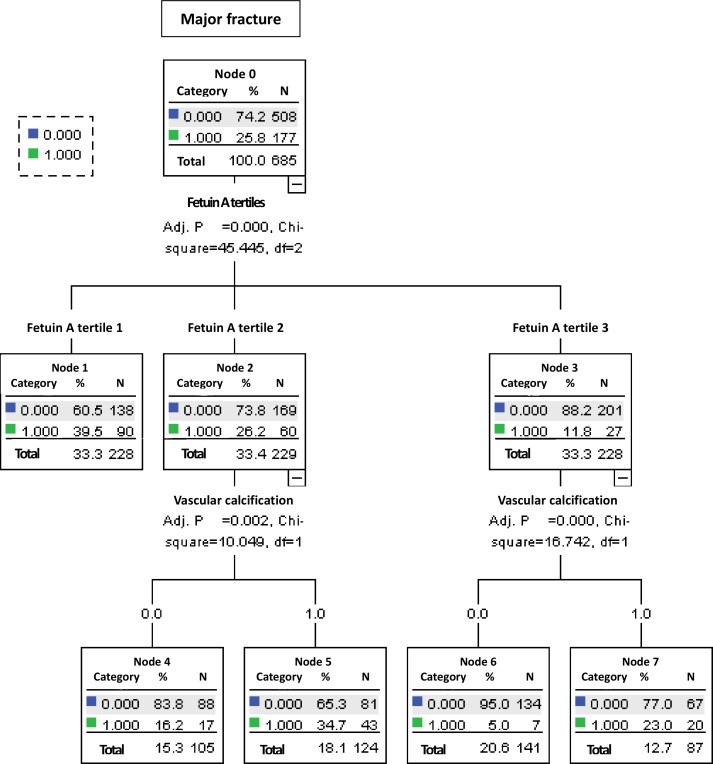
Classification tree based on recursive partitioning analysis.